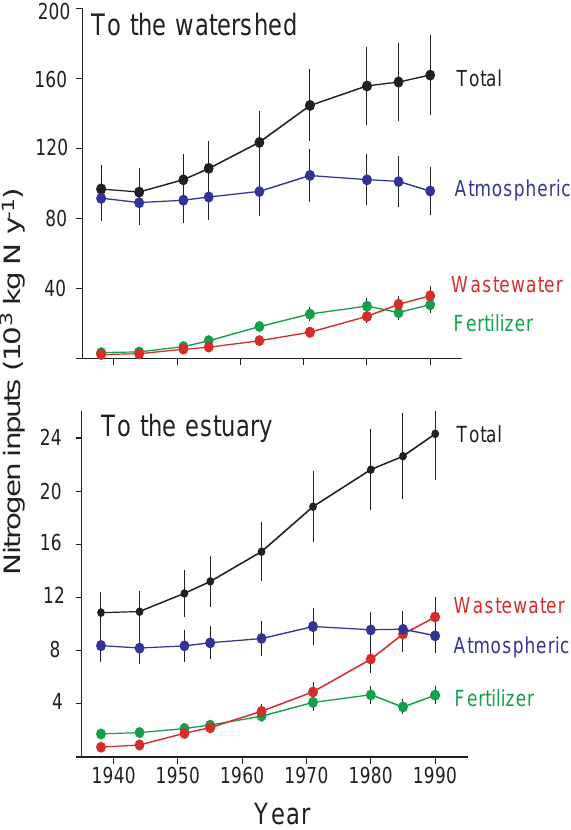
F IG . 2. – Estimates of land-derived nitrogen loads to the Waquoit Bay watershed surface (top panel), and to the estuary (bottom panel). Loads from wastewater (red), atmospheric (blue), and fertil- izer (green) sources were estimated based on changes in land use from 1938 to present. Total loads shown in black. From Bowen and Valiela